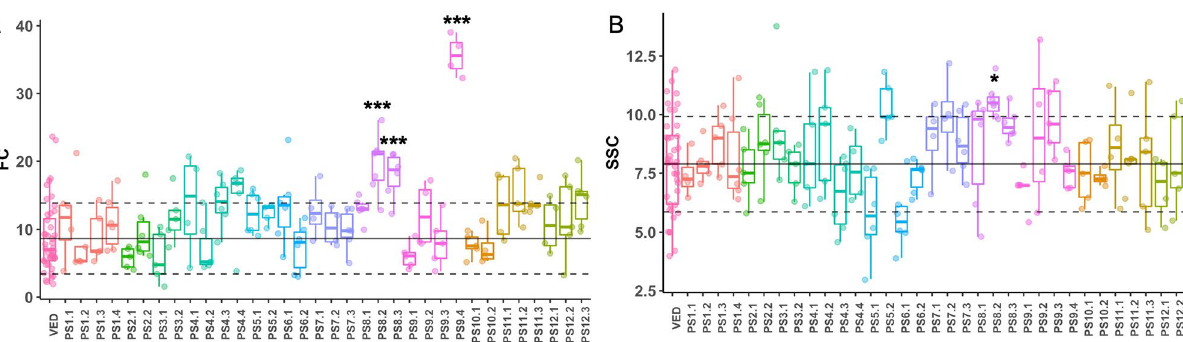
Figure 4. Boxplot representing FC and SSC values for ILs. Each dot represents a replicate, the black solid line corresponds to the average and the grey dashed lines to the average ± SD of the recurrent parent Ved. Significant differences are marked with asterisks: *< 0.05, **< 0.01, ***<